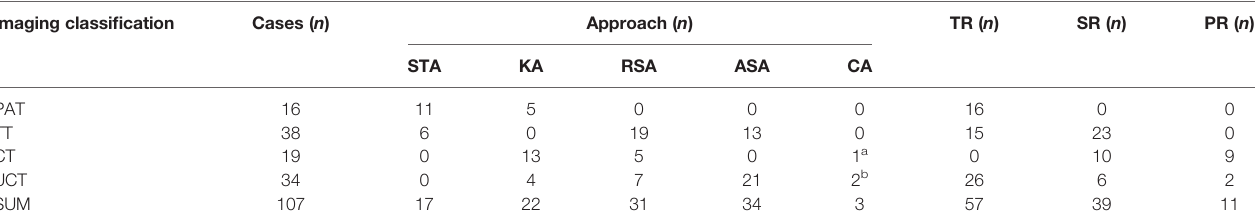
TABLE 1 | Selection of surgical approaches based on imaging classi fi cation. Imaging classi fi